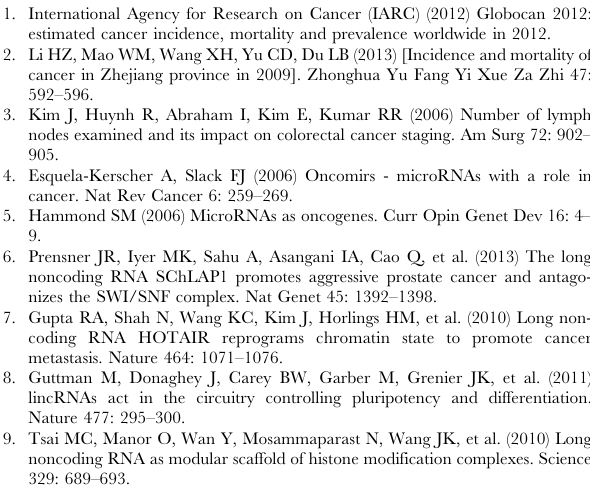
Figure 13. The number of cells that invaded or migrated through the chamber was evaluated in 5 fields for each experimental group and averaged. The number of invasive or migrated cells for each experimental group was counted as the average of 5 five fields of vision under a microscope (* P , 0.05). Figure S1 The relationship between copy number variation and 91H expression in tumor tissues and adjacent normal tissues. (TIF) Figure S2 91H relative expression was quantified in four CRC cell lines and a normal human intestinal